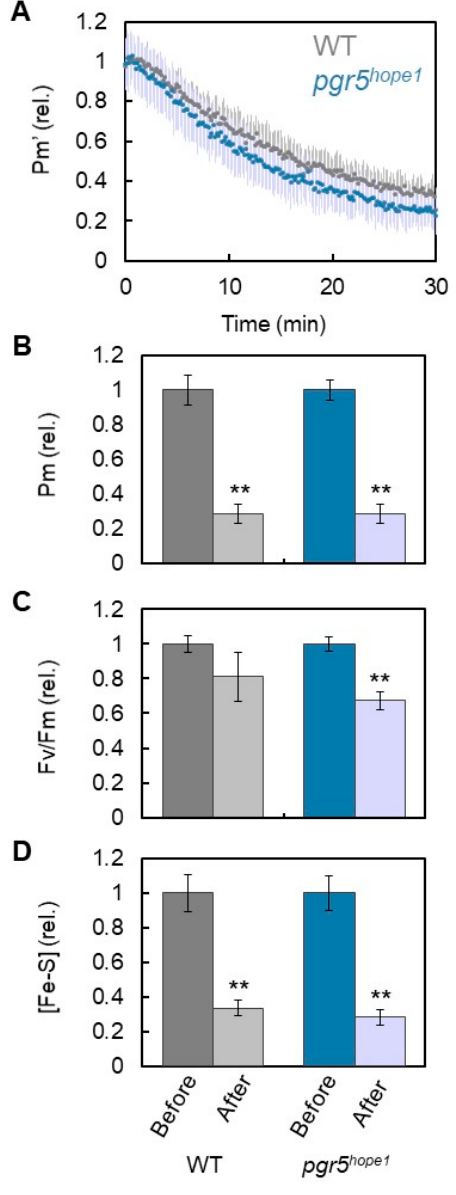
Figure 2. Effects of rSP light illumination on the incident photo-oxidizable P700 (Pm’), photo-oxidizable P700 (Pm), maximum quantum efficiency of PSII (Fv/Fm), and amount of Fe/S in wild-type (WT) and pgr5 hope1 Arabidopsis. The leaves were illuminated every 10 s with short-pulse light (300 ms) of 15,000 µ mol photons m − 2 s − 1 under the atmospheric conditions (40 Pa CO 2 / 21 kPa O 2 ) for 30 min. The rSP light illumination started at 0 min. ( A ) Pm’. Black, WT; magenta, pgr5 hope1 . The mean values were normalized to the primary values before the rSP light treatment; error bars represent the standard deviation; data were acquired from six biological replicates. ( B ) Pm, ( C ) Fv/Fm, and ( D ) Fe/S were compared before and after the rSP light illumination treatment in WT and pgr5 hope1 . These parameters were evaluated after the illuminated leaves were left for 1 h in the dark. Each value was normalized to the value before the rSP light illumination treatment. ** p < 0.01 (Welch’s t